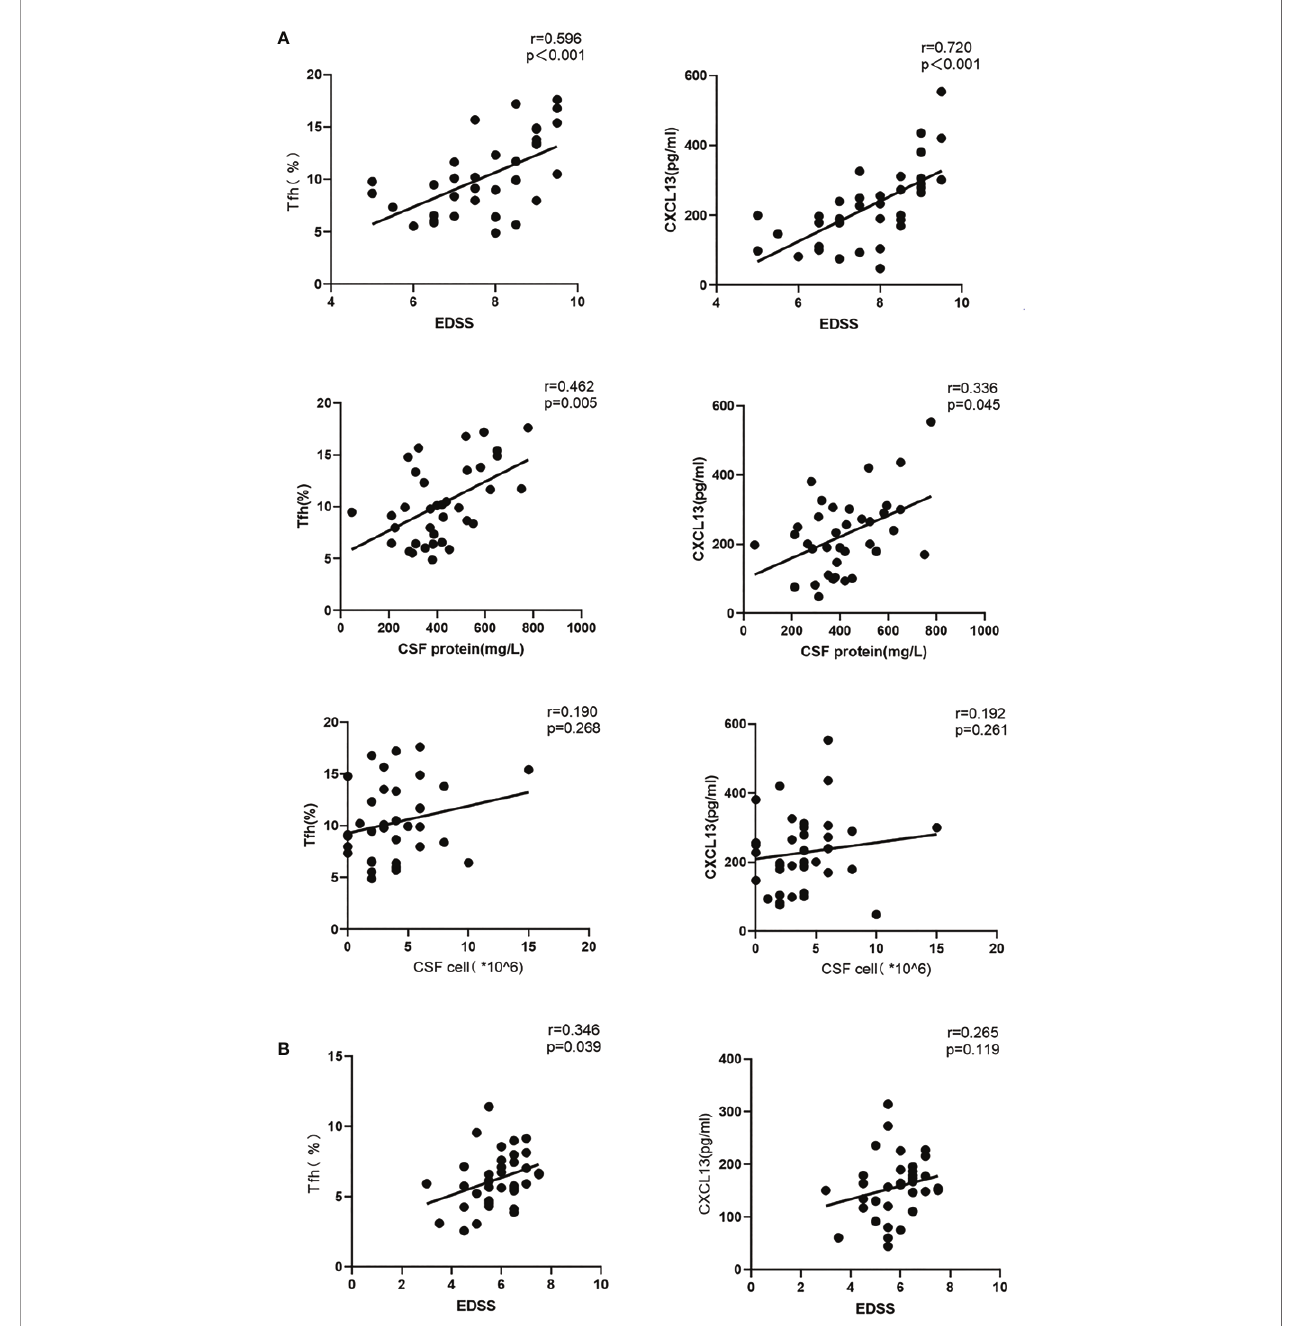
FIGURE 2 | Correlations among the circulating Tfh cell ratio, CXCL13 levels, EDSS scores, CSF protein levels and CSF cell numbers in the acute and recovery stages of NMOSD (A) acute stage; (B) recovery stage. r: correlation coef fi